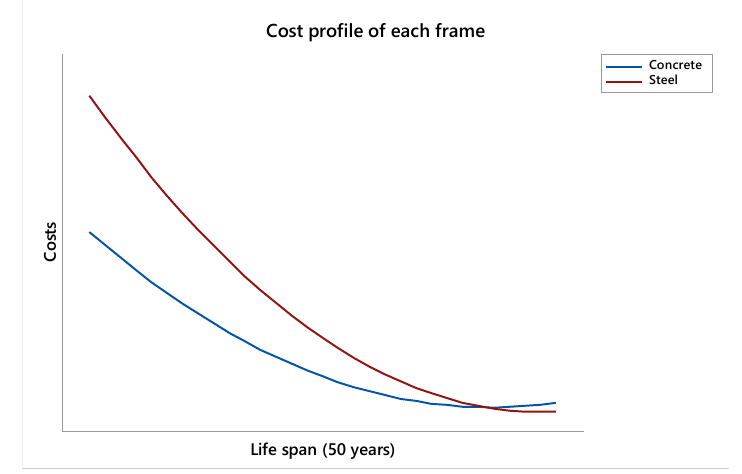
Figure 6. Cost profile.